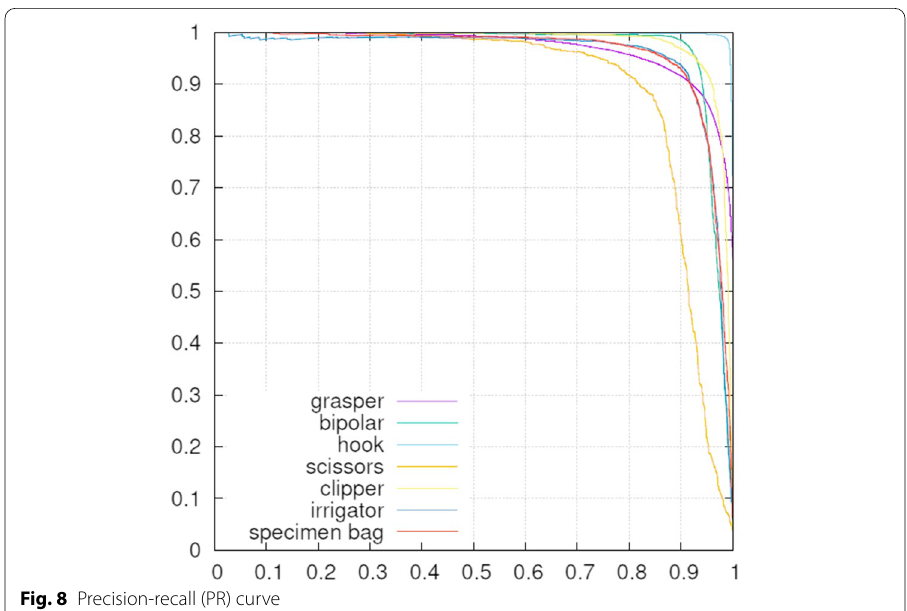
Fig. 8 Precision-recall (PR)